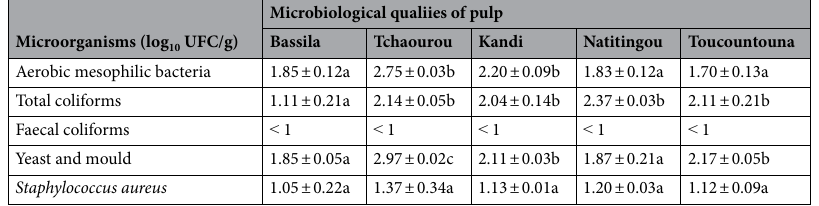
(Table 1). The number of aerobic mesophilic bacteria in all collected samples was close to the international standard of 4 log10 CFU/g 28,29 . However, the highest microbial count was found in sample collected in Tch- aourou and Kandi parks, while the lowest microbial count was observed in fruit pulp from Bassila, Naitingou and Toucountouna. Difference between parks for the number of yeasts and moulds (p ≤ 0.001) and total coli- forms (p ≤ 0.001) were observed, with samples collected from Tchaourou park giving significantly higher values of yeasts and moulds compared with the samples from other parks. Water and environment may play a major role in the yeasts and moulds contamination of P. butyracea fruit pulp especially during washing of fruits. The highest count of yeasts and moulds is also due to the acidic nature of P. butyracea fruit pulps which probably favours the growth of yeasts. Moreover, no faecal coliforms were detected in all fruit pulps. Furthermore, there is no significant difference in Staphylococcus aureus counts between the fruit pulp collected in various parks (p > 0.05). The presence of Staphylococcus aureus in the fruit pulp is attributed to its wide spread in the environ- ment. The primary habitat of these organisms are the interior body and skin of man and animal from where this microbes are transferred to the fruits and subsequent transfer to the fruit pulp during treatment. However, the level of all microbial enumerated in P. butyracea fruit pulps was under the detection limit. The acidity of pulps could be a factor that limited the development of spoilage and pathogen microorganisms in pulps.